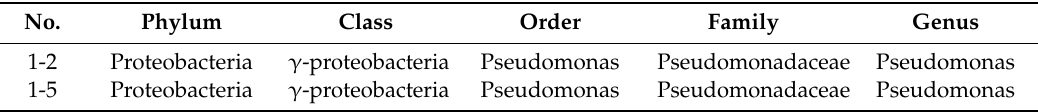
Table 4. Filtered water